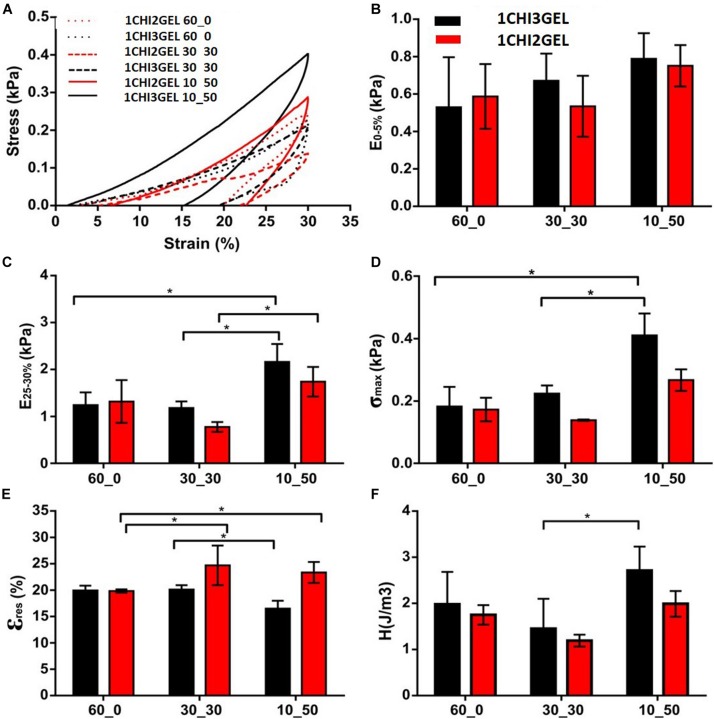
Mechanical characterization of 3D printed chitosan-gelatin scaffolds. (A) Representative stress-strain curves obtained for the 60_0, 30_30, 10_50 crosslinking conditions, and for the considered ratio (1CHI2GEL and 1CHI3GEL). Mechanical parameters calculated from the curves: (B) elastic modulus, (C) stiffness, (D) maximum stress, (E) residual deformation and (F) hysteresis area (*p < 0.05).